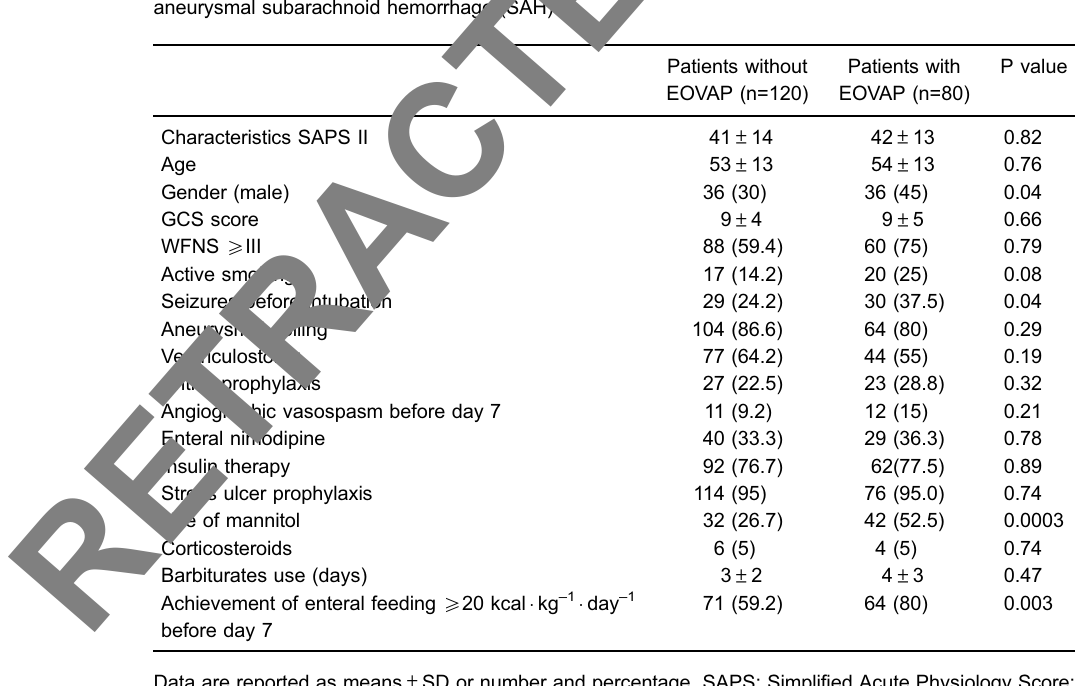
Table 1. Risk factors analysis for early-onset ventilator-acquired pneumonia (EOVAP) in patients with aneurysmal subarachnoid hemorrhage